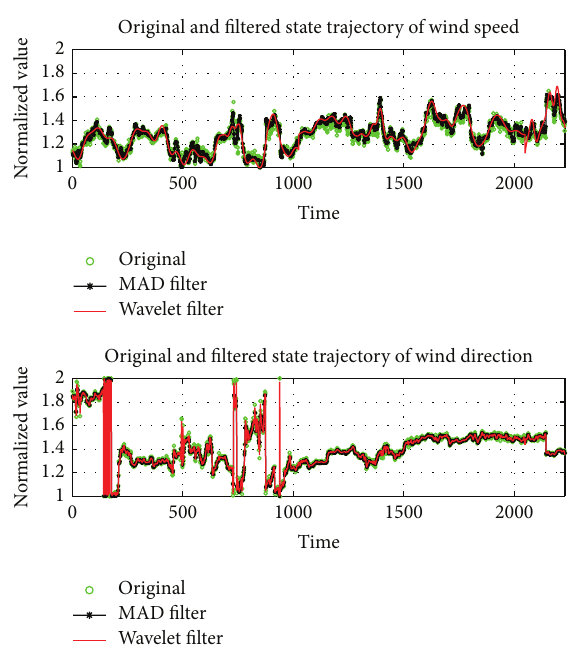
Figure 2: State trajectories refer to the 1st variable and 2nd variable.